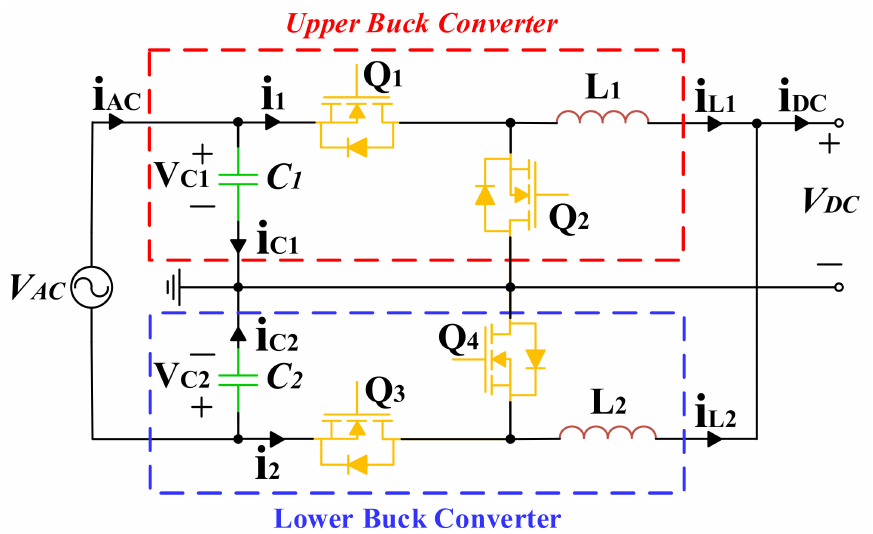
Figure 10. Two bidirectional buck-type differential rectifier configurations used for the inductor current waveform